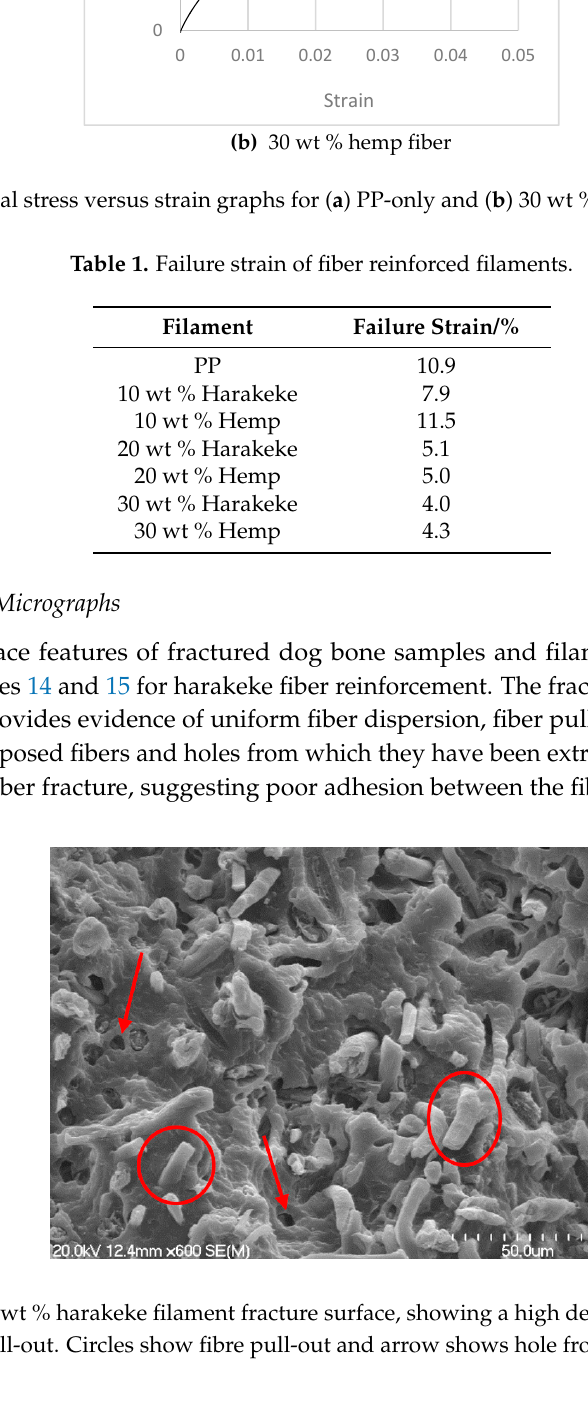
Figure 14. The 20 wt % harakeke filament fracture surface, showing a high degree of fiber dispersion, alignment and pull-out. Circles show fibre pull-out and arrow shows hole from where fibre has been pulled out